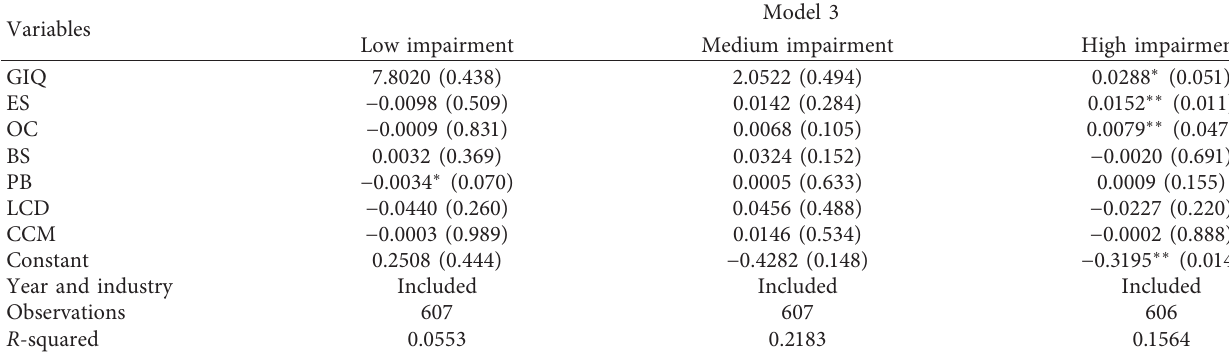
Table 6: Regression results of Hypothesis